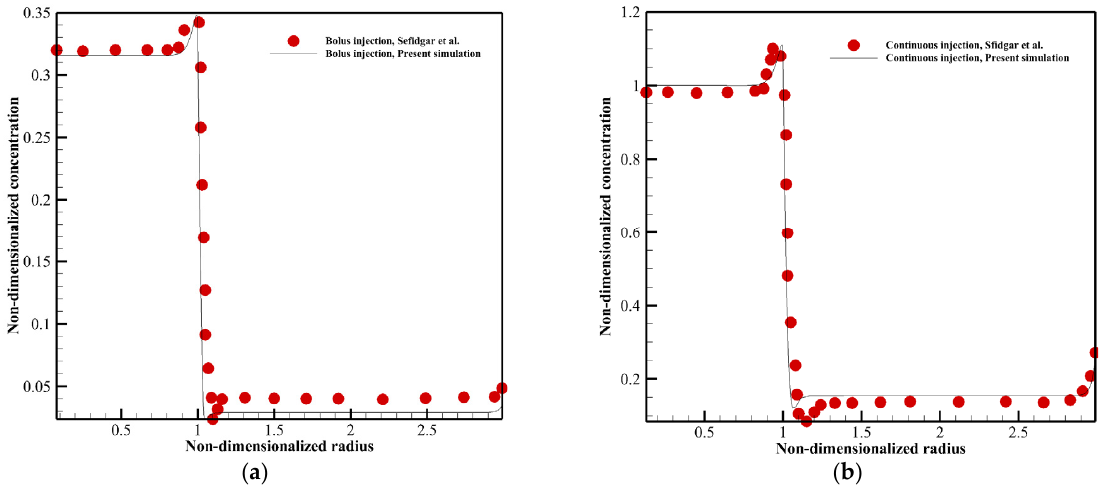
Figure 6. Comparison between the result of the present model and literature [23]. A tumor ( R = 1 cm) surrounded by normal tissue is studied in this figure. ( a ) Interstitial 2 ( ) F ab ′ concentration in 8 h post-injection with bolus injection. ( b ) Interstitial 2 ( ) F ab ′ concentration in 72 h post-injection with continuous injection.